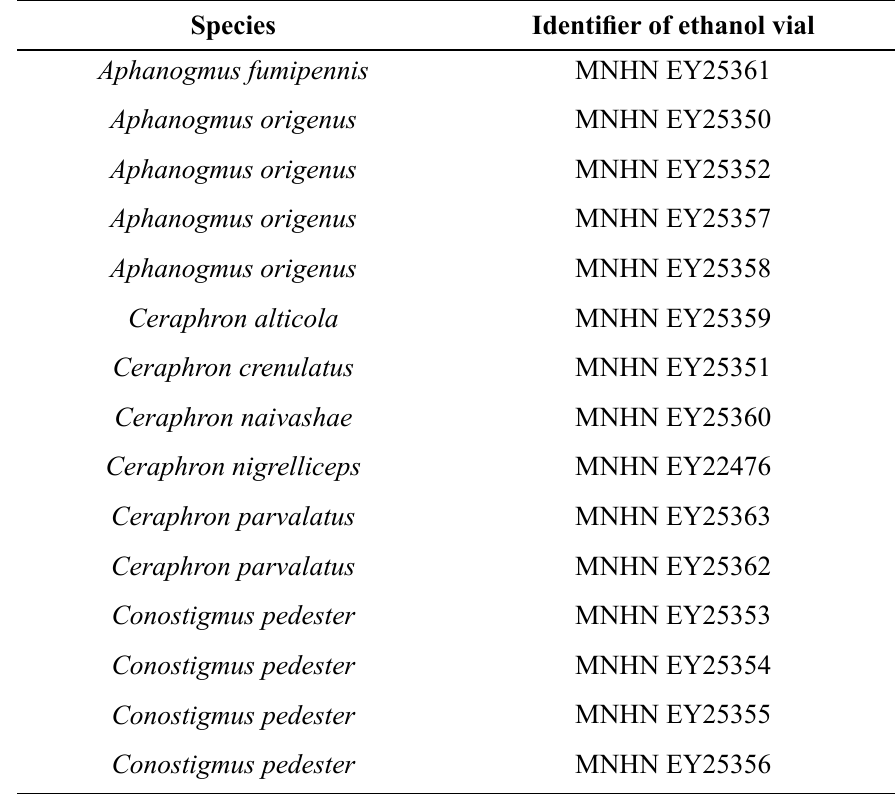
Table 2. A list of all Ceraphronoidea type specimens stored in ethanol at the Muséum national d’histoire naturelle, Paris (MNHN) and their associated